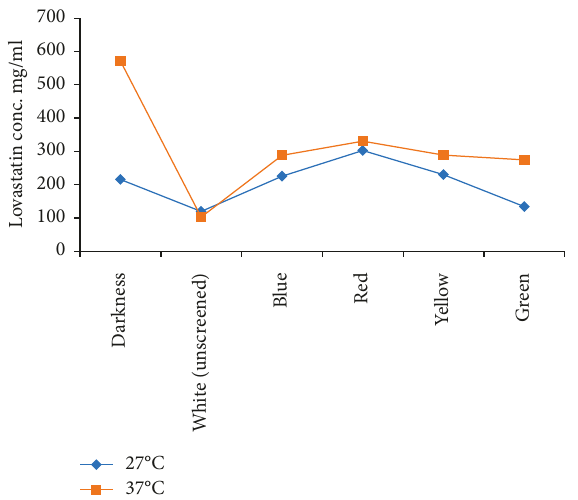
Figure 5: Extracellular lovastatin concentrations (mg/ml) at 27 ° C and 37 °